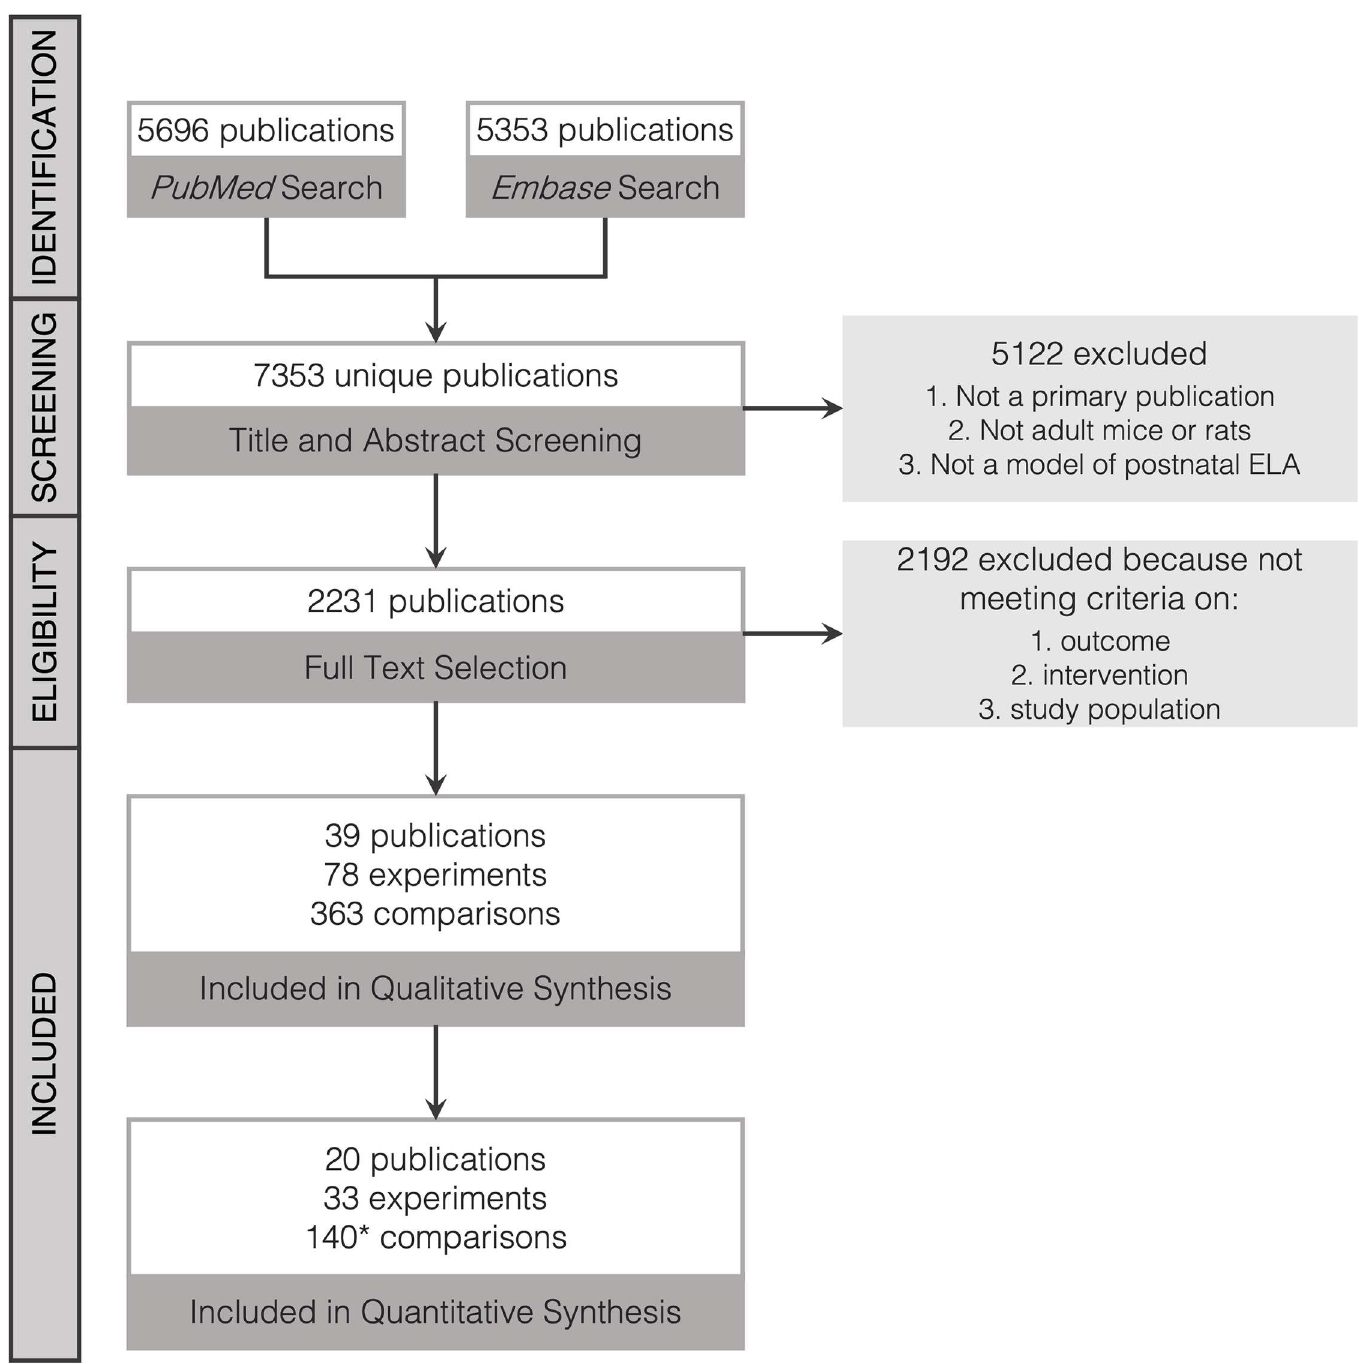
Fig 2. Flow-chart of study selection process. ^ = not included in pre-specified inclusion/exclusion criteria (S1.1 in S1 File). https://doi.org/10.1371/journal.pone.0253406.g002 publication, 2) not using adult ( > 8 weeks) mice or rats which are younger than 1 year, 3) not using a postnatal model of ELA as specified in S1.1 in S1 File. Eligibility was then determined by full-text screening of the remaining studies by at least two blinded investigators (HS, EK, LvM), with a random subset screening performed by a fourth (VB), blinded investigator to